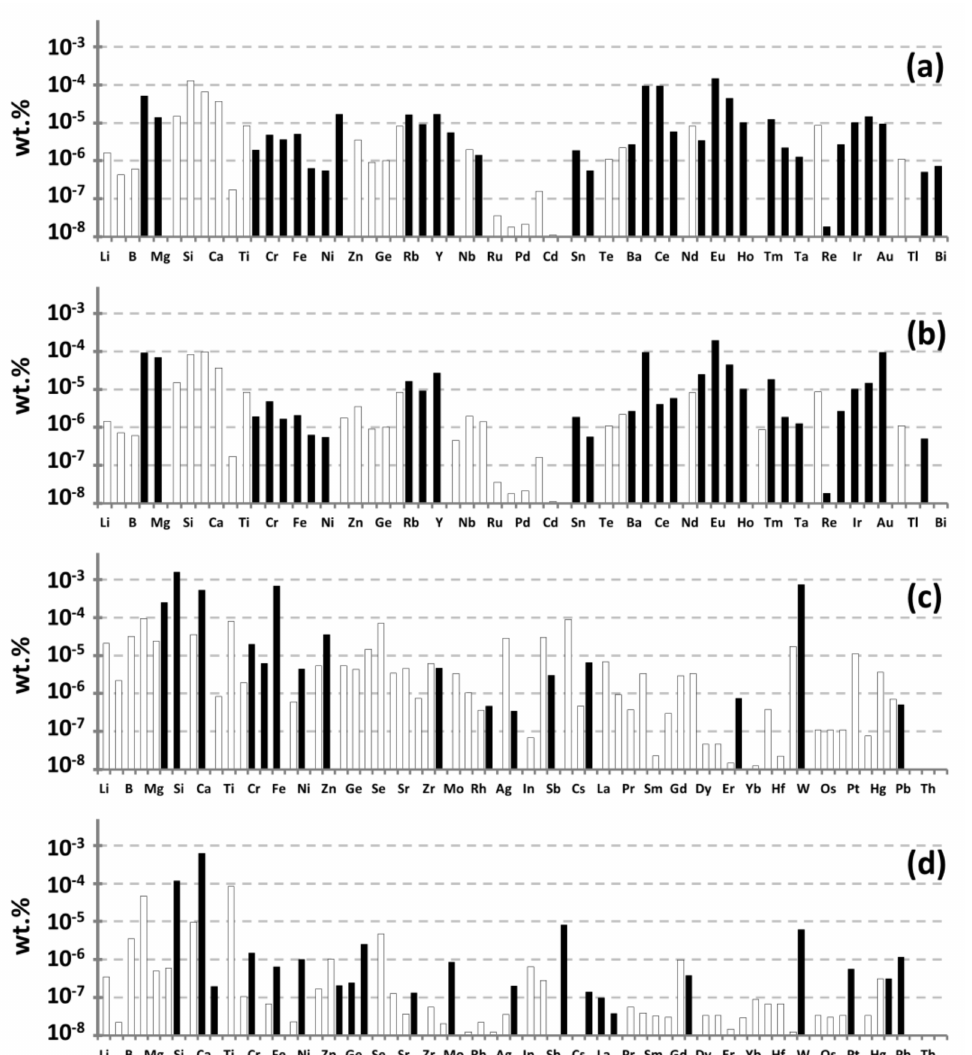
Figure 5. The impurity composition of Gd-05 ( a ), Gd-06 ( b ) GdCl 3 preparations and PMMA of various manufacturers ( c ) Voxeljet AG, (Germany); ( d ) RND Polymer (Russia) measured by ICP-MS. The empty bars present the limits of determination of the corresponding